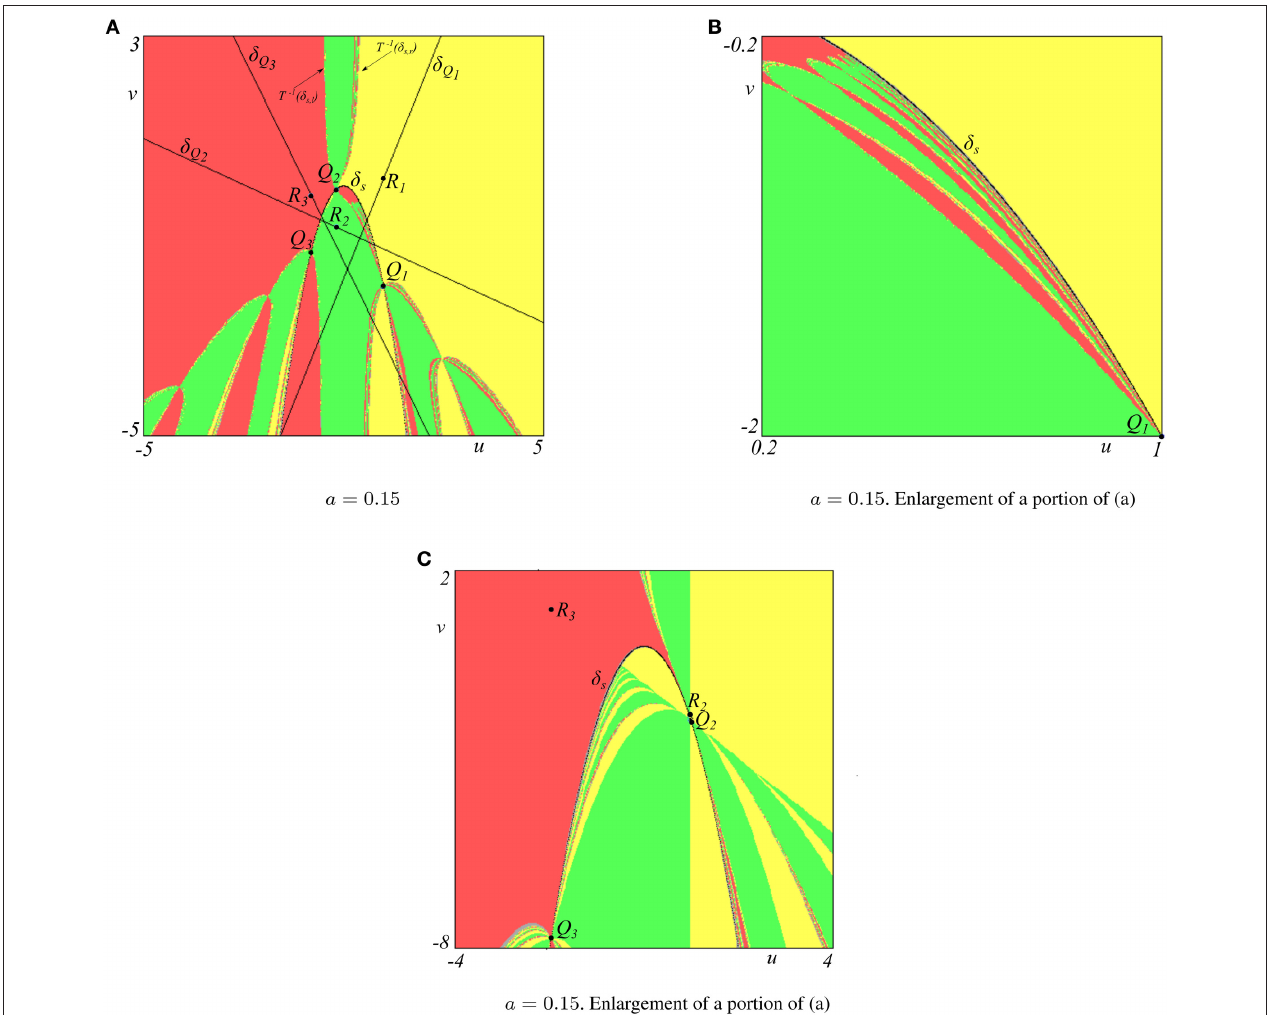
FIGURE 5 | (A) The three basins of attraction of the fixed points are represented with different colors. The yellow region represents the points belonging to the basin of R 1 , the green color represents the points belonging to the basin of R 2 while the red color represents the points belonging to the basin of R 3 . The points Q 1 , Q 2 , and Q 3 are the focal points. (B,C) display two enlargements of (A) with infinitely many lobes issuing from the focal points.